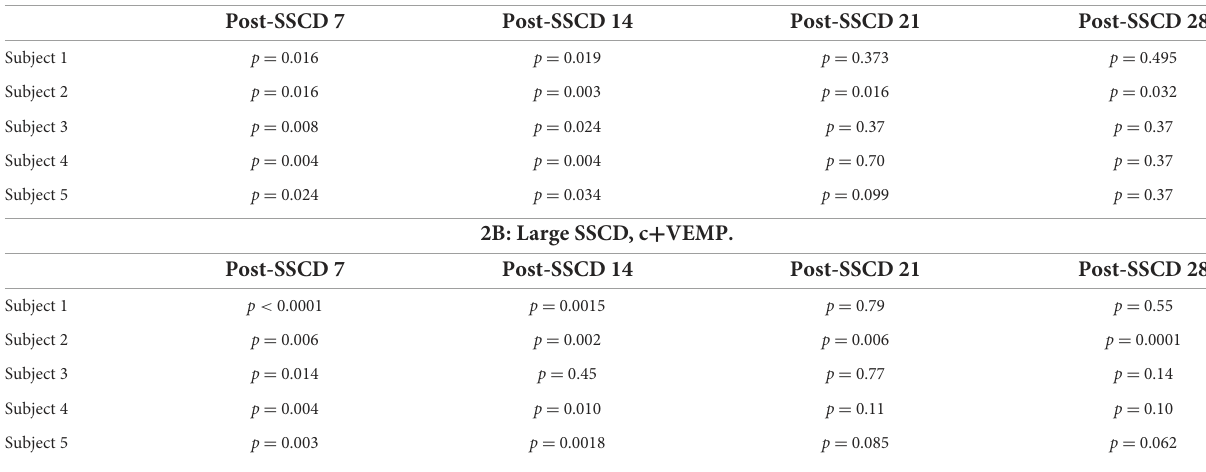
TABLE 2 Recovery of ABR and c + VEMPs after Large